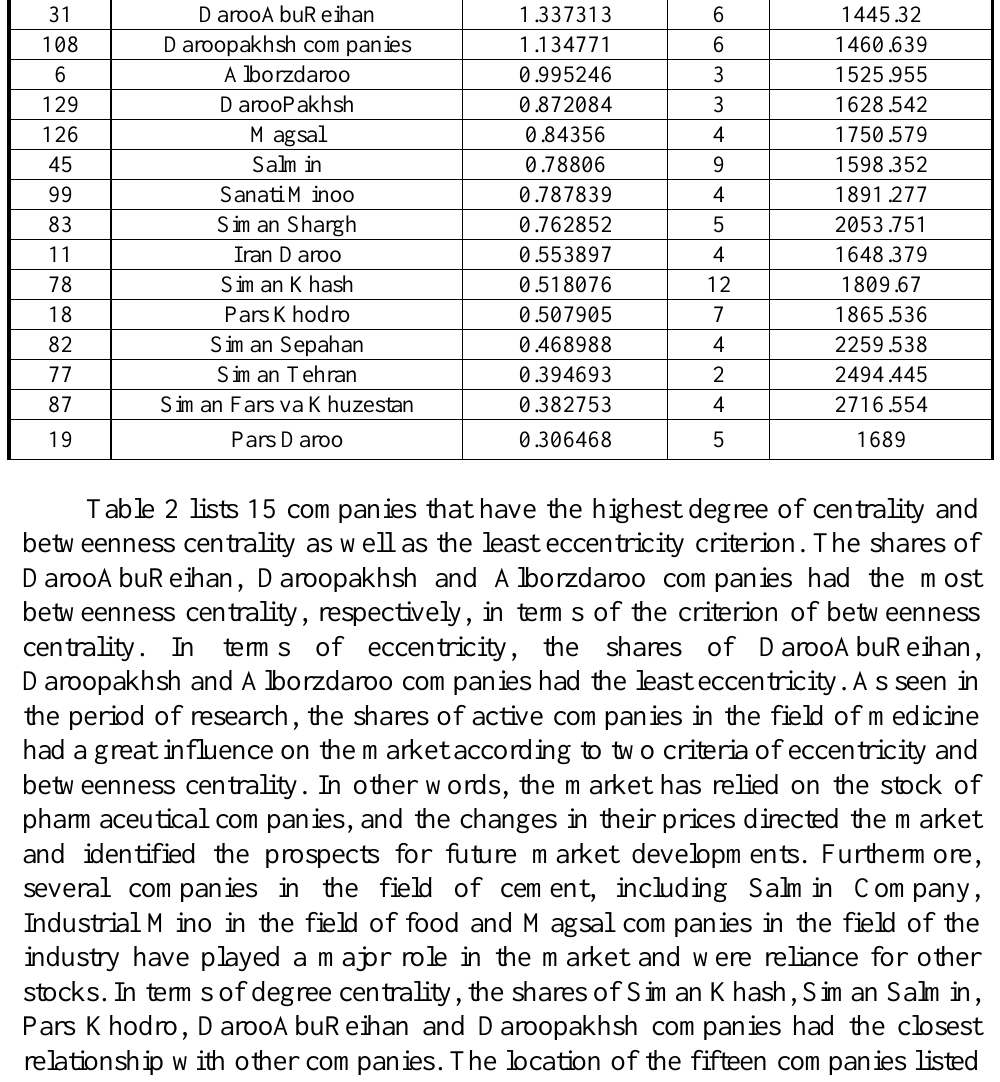
Betweenness centrality